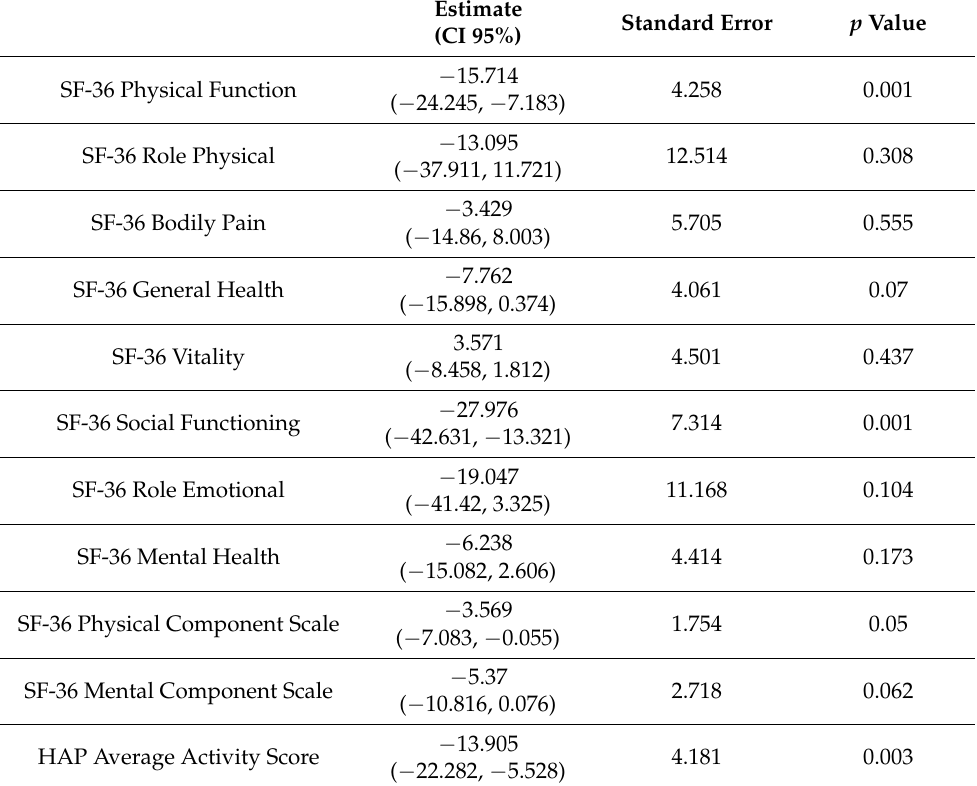
Table 4. Linear regression